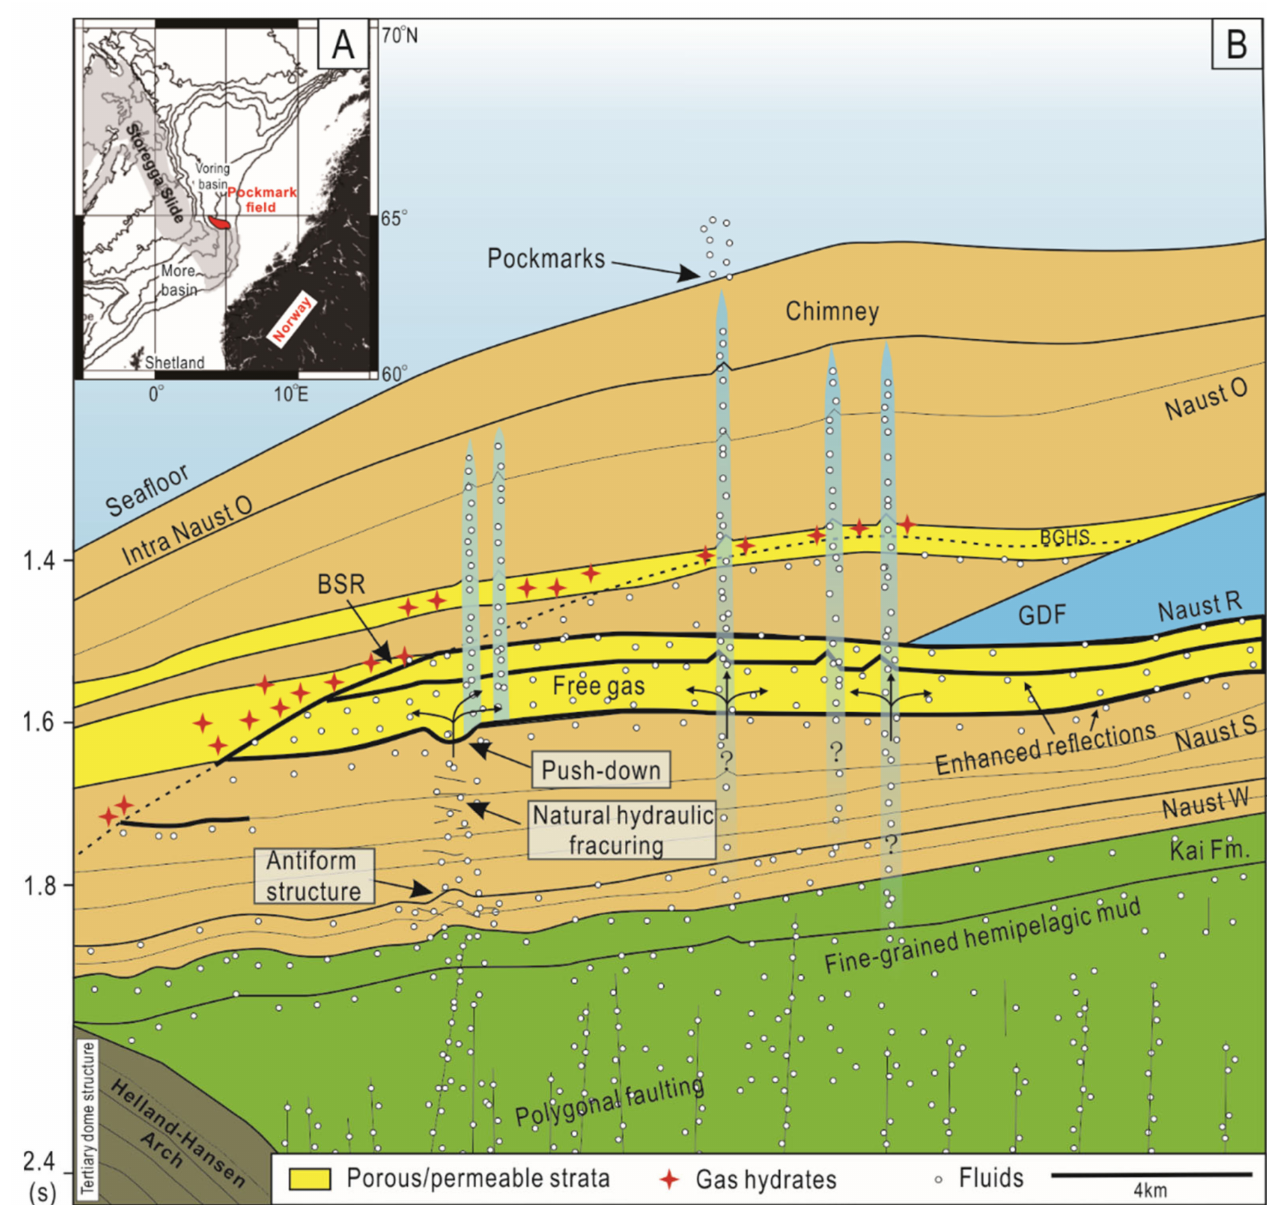
Figure 9. ( A ) Location of the gas chimney field (i.e., pockmark field) in the Nyegga area, Norwegian margin. ( B ) Schematic model of the chimney-related hydrates and fluid flow system, illustrating the interaction of deep geological structures with a shallower migration pathway system for fluids and gases (cited from